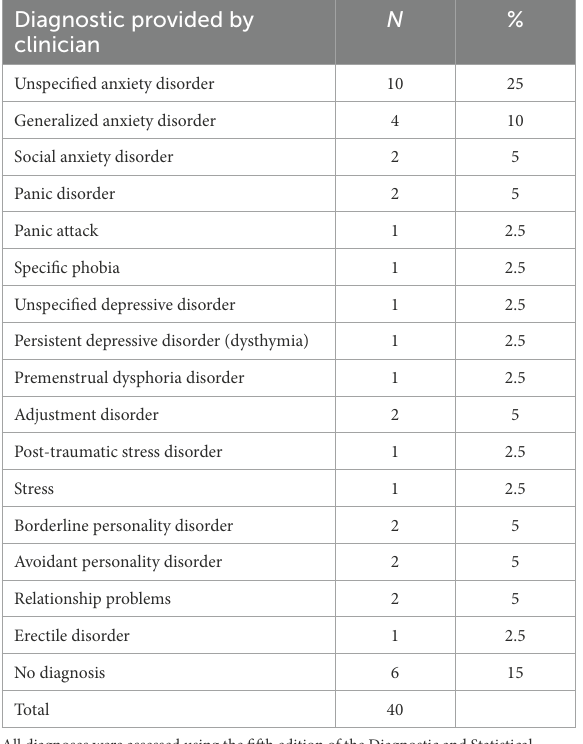
TABLE 1 Diagnostic characteristics of the patients ( N = 40).